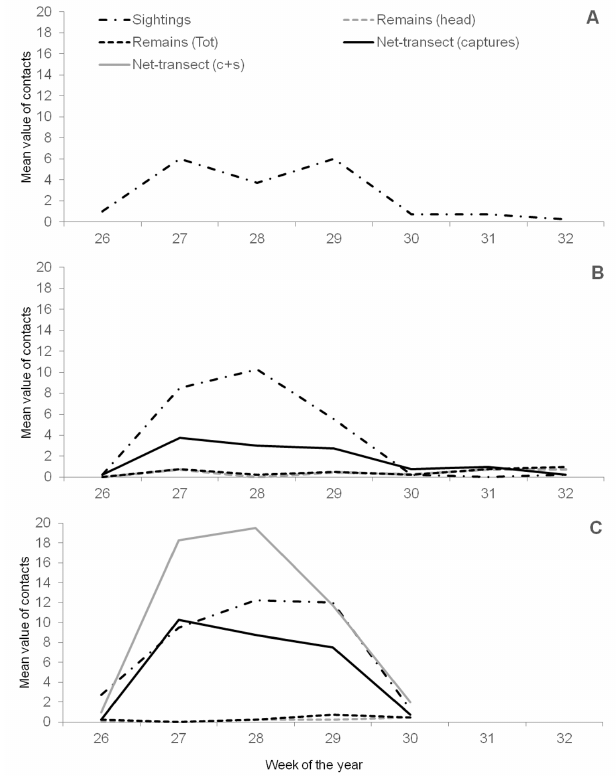
Figure 12. Phenology of the stag beetle L. cervus at Foresta della Lama during A 2014 B 2015 C 2016. Black dashed-pointed line is the mean value of Sightings; Black dashed line is the mean value of Remains collected along transects; Grey dashed line is the mean value of Remains (heads). Black line is the mean value of captures by Net-transect; Grey line is the mean value of the sum of capture specimens and sight- ings performed by Net-transect. Weeks are expressed as the corresponding week of the year.